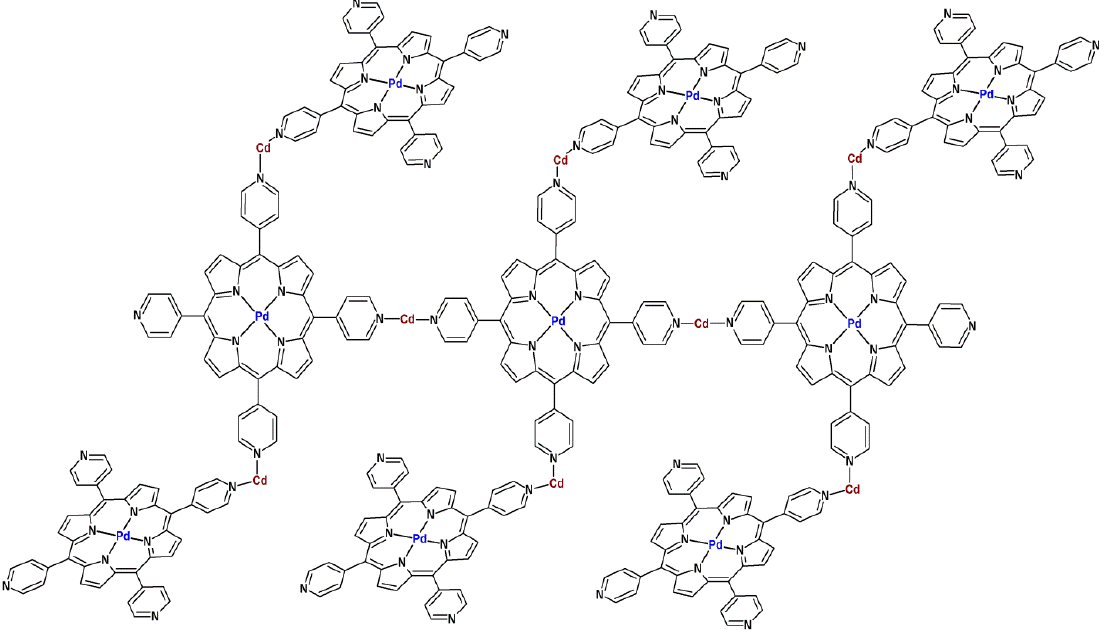
Figure 5. First porphyrinic MOF consisting of [tetra(4-pyridyl)porphyrinate] Pd(II) interconnected by cadmium(II) ions in a three-dimensional infinite net, as reported by Robson et al. [104]. Nitrato and aqua ligands have been omitted for